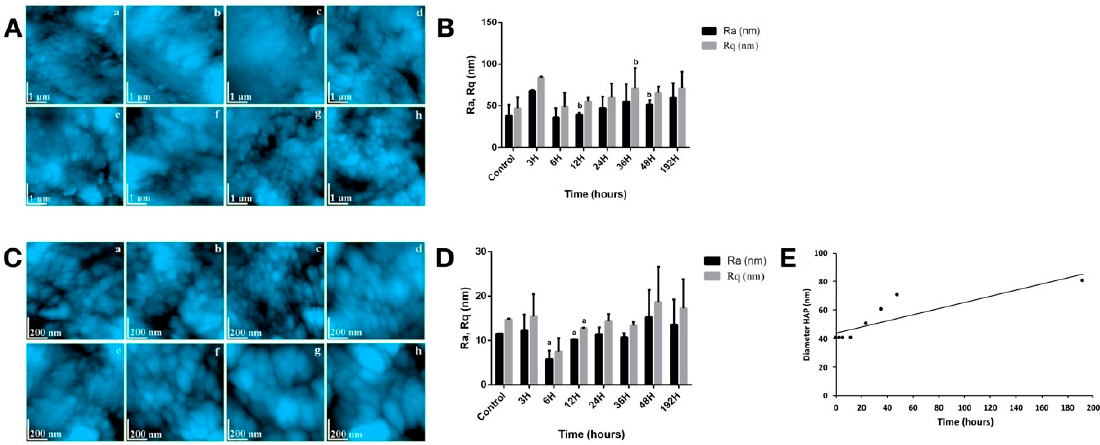
Figure 3. ( A ) Dentin fine microstructure: (a) CTR, (b) 3H, (c) 6H, (d) 12H, (e) 24H, (f) 36H, (g) 48 H, (h) 192H; ( B ) roughness surface of dentin fine microstructure; ( C ) dentin nanostructure: (a) CTR, (b) 3H, (c) 6H, (d) 12H, (e) 24H, (f) 36H, (g) 48 H, (h) 192H; ( D ) characteristics of dentin nanostructure; ( E ) HAP crystallite diameter. For ( B , D ), values are expressed in mean ± SD. a p < 0.05 compared to CTR group; b p < 0.05 compared to IRD3 group .